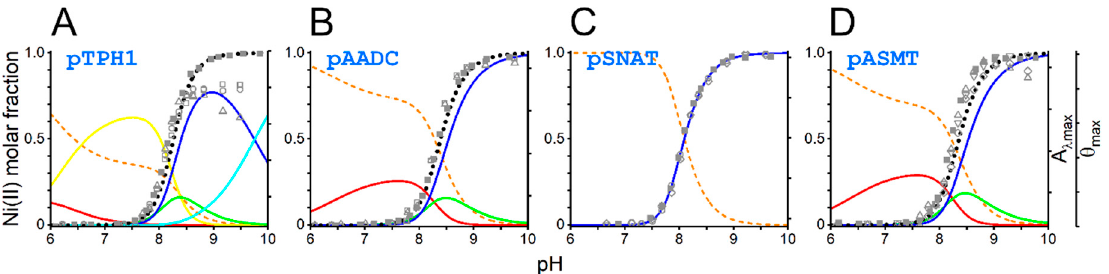
Figure 5. Speciation of Ni(II) complexes with peptides pTPH1 ( A ), pAADC ( B ), pSNAT ( C ), and pASMT ( D ). The common left axis shows Ni(II) complexes molar fractions. Common right axes show either absorbance at a maximum of the d-d band or ellipticity at the extrema of respective d-d bands. Shown are Ni(II) aqua ions (orange dashed line), 1N (N Im ; red), 2N (N Im , N Im ; yellow), 3N (N amide , N amide , N Im ; green), 4N (N amide , N amide , N amide , N Im ; dark blue and light blue), and a sum of 3N and 4N (black dotted line) complexes. Presented are overlayed values of absorbance (full gray symbols) and CD (empty gray symbols) values.